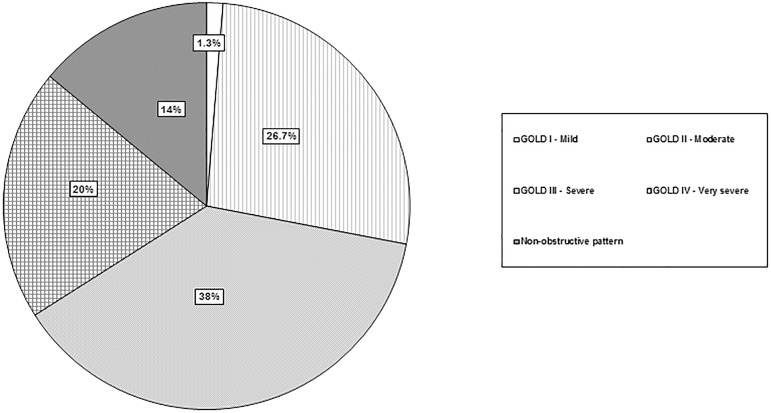
Severity of patients with bronchiectasis secondary to COPD according to GOLD staging.COPD: chronic obstructive pulmonary disease.